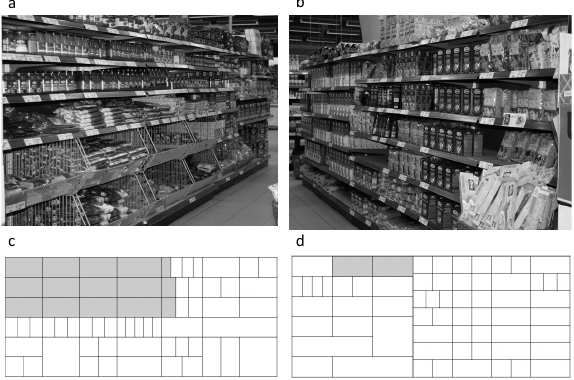
Figure2. The shelves used in the study. Panels a and b show photos of the shelves on both sides of the aisle, panels c and d schematic drawings of the same shelves. The grey areas in panel c and d contain non-pasta